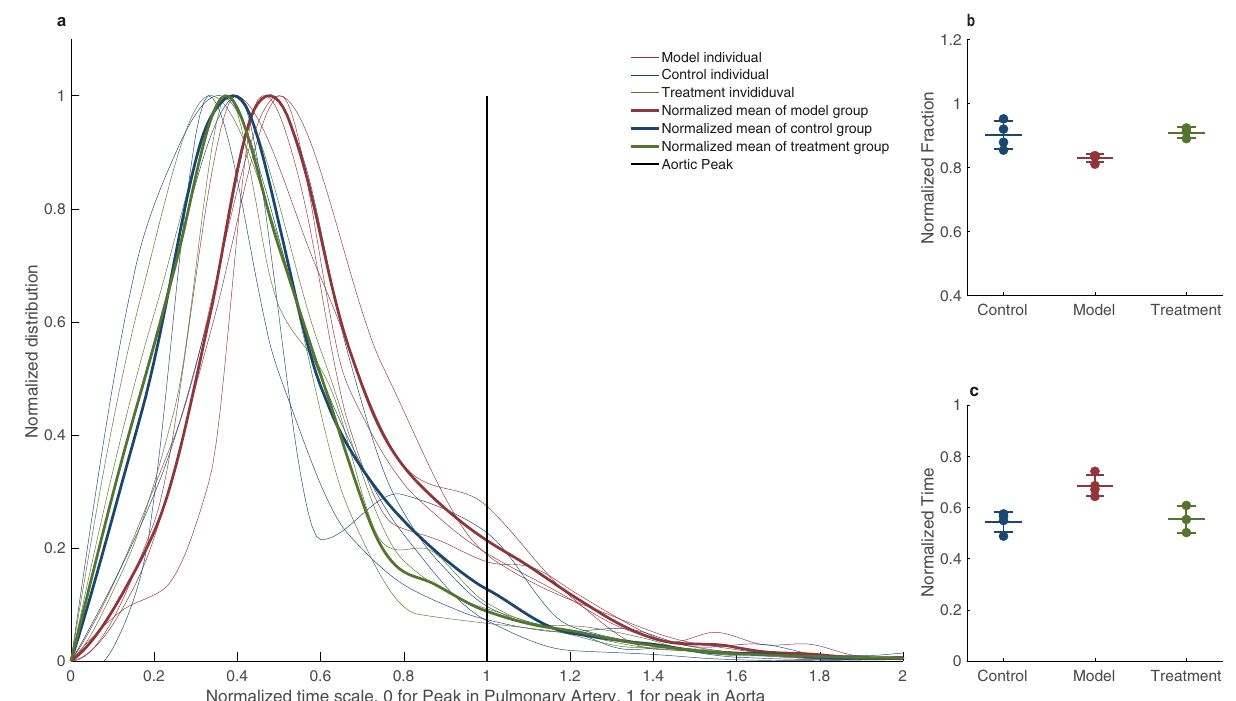
2 Normalized time scale, 0 for Peak in Pulmonary Artery, 1 for peak in Aorta Fig. 7 Time-to-peak distribution in lungs of swine. a The distribution of peaks in every individual is plotted with the thinner lines and a solid line represents the mean peak distribution throughout the lungs. In all graphs, red represents the model group, blue represents the control group and, green represents the treatment group. The vertical black bar represents the aorta peak and the cutoff for functional ratio, calculated as the proportion of lung with delayed perfusion (peaking after the aorta). b Individual functional ratios represented by dots and a mean bar with standard deviation whiskers for each group of control ( n = 4), model ( n = 4), and treatment ( n = 3). c The mean time-to-peak of the lungs with each individual as a scatter plot and mean and standard deviation as whiskers. Source data are provided as source data fi